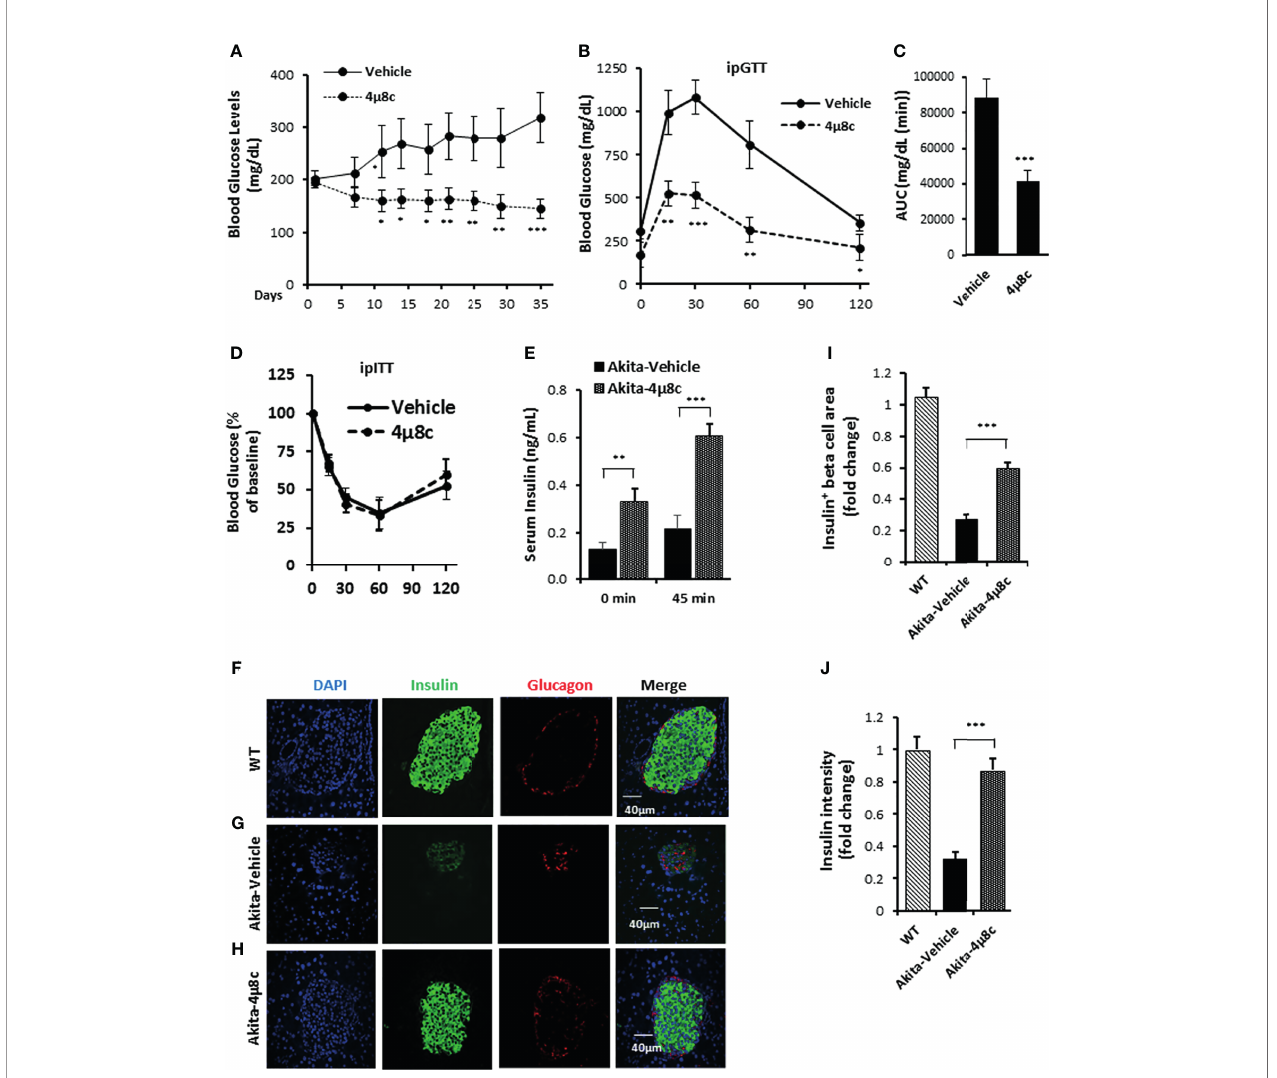
FIGURE 7 | 4 m 8CamelioratesdiabeticconditionsofAkita mice andinhibitsIRE1 a RNaseactivity. (A) Fasting bloodglucoselevelsweremeasuredinAkita mice treatedwith vehicle(n= 7) or4 m 8C(n=6) atindicatedtimepoints. (B,C) Glucosetolerance test.Bloodglucoselevels (B) measuredatindicatedtimepointsafterintraperitonealinjectionof glucose (1.5g/kgbodyweight)following6-hfasting andtheAUC (areaunderthecurve, C ). (D) Insulintolerancetest. Bloodglucoselevelsmeasuredatindicatedtimepointsafter intraperitonealinjectionofinsulin(0.75 IU/kgbodyweight)following4-hfasting. (E) Invivoglucose-stimulatedinsulinsecretion. Serum insulinlevelsmeasuredatindicatedtime points after intraperitonealinjectionofglucose(1.5g/kgbodyweight) following 6-hfasting. (F – H) Immuno fl uorescence stainingofpancreaticsections.Pancreasesweresectioned andslideswerestainedwithanti-insulinantibody(green, b -cellmarker),anti-glucagonantibody(red, a -cellmarker), andDAPI(blue).Slides wereimagedwithanOlympusFV1000 confocalmicroscope. (I) Quanti fi cationofinsulin + b -cellarea. Totalareaofallisletsper sectionwascalculatedfrom atotalofsixsections foreachofthreemiceusing insulin + cells todemarcateislet b -cellsandnormalizedwiththatfor C57B/6micedesignatedas 1. (J) Insulinstainingintensity. The averageinsulinstainingintensitywasquanti fi